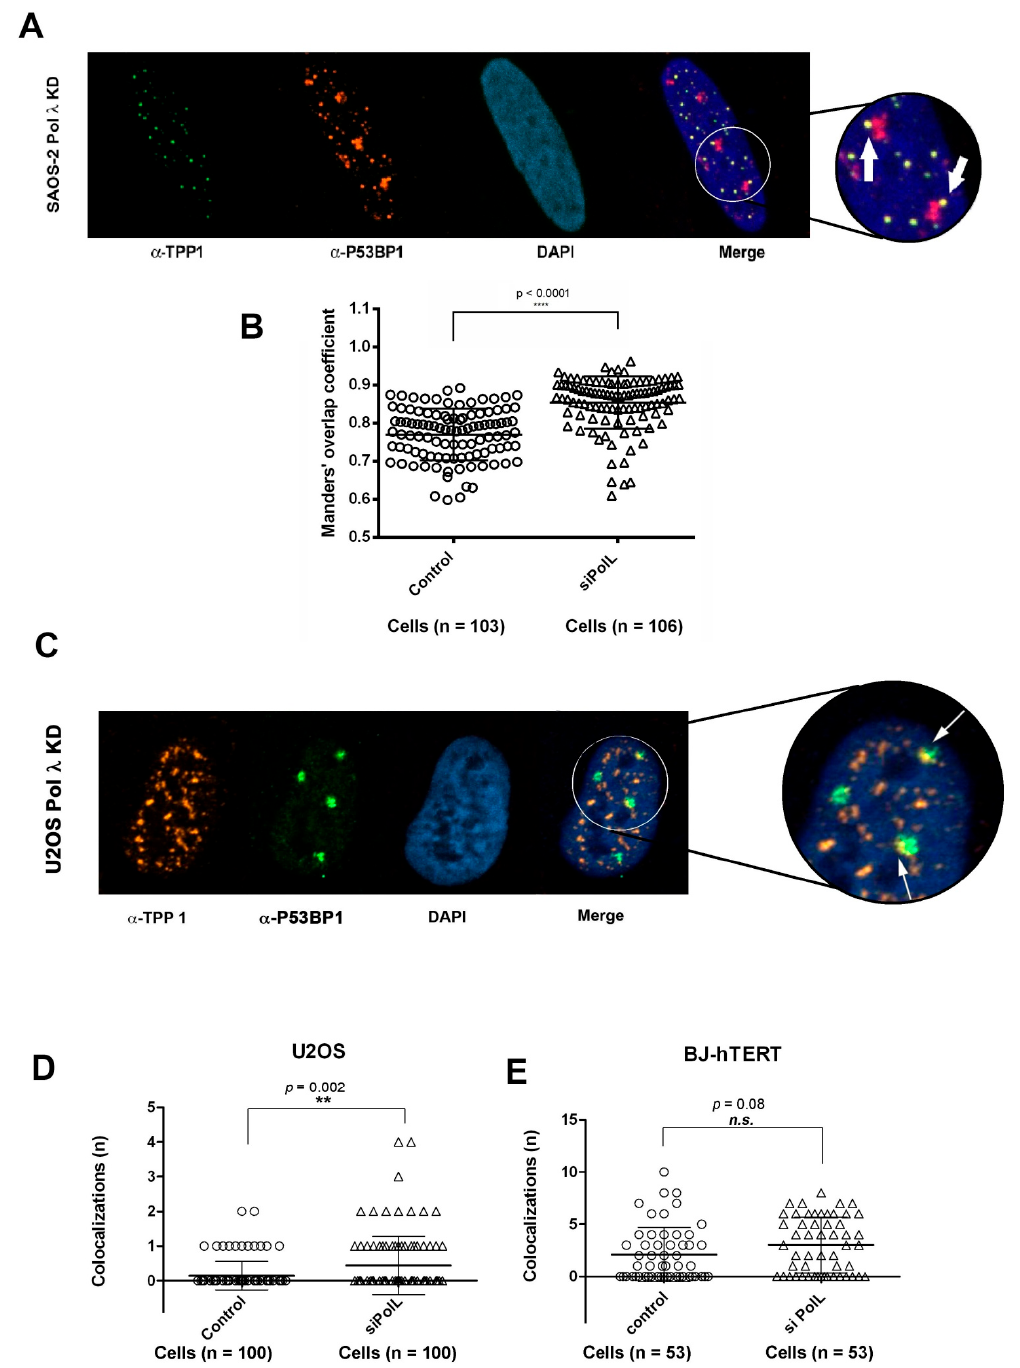
Figure 8. DNA polymerase λ silencing causes telomere stress specifically in ALT cells. ( A ) Confocal microscopy imaging of TPP1 colocalization with P53BP1 (telomere dysfunction foci, TIF) in Saos-2 cells silenced for Pol λ . The white arrows indicate representative colocalization events (TIF). ( B ) Quantification of TPP1-P53BP1 colocalization events through